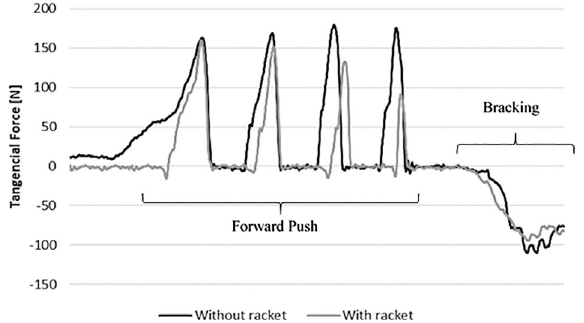
Figure 2 - Tangential force measured by SmartWheel . Comparison between accelerated straight maneuvers with and without